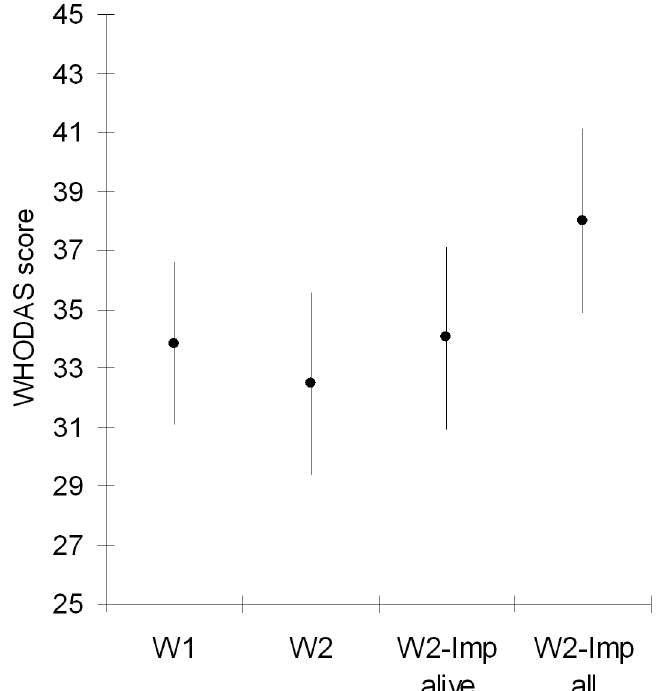
Figure 4. Mean and 95%CI of WHODAS disability scores for: all patients at baseline (W1, left); survivors at end of follow- up (W2, centre-left); survivors at end of follow-up in W2, with imputed values for subjects alive but not-assessed in W2 (centre-right); and, survivors at end of follow-up in W2, with imputed values for all not assessed in W2, including deceased